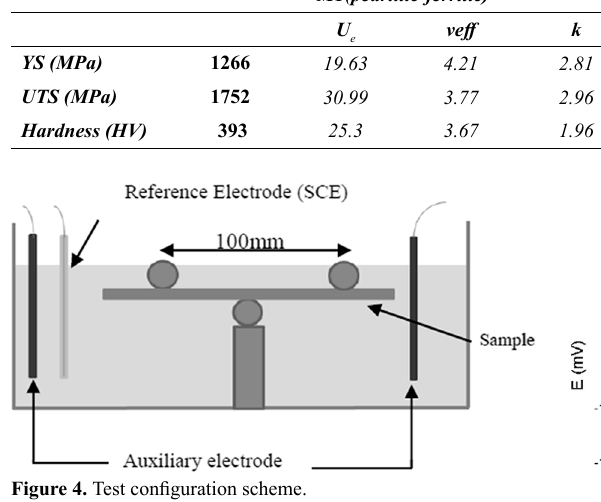
Table 2. Results for mechanical properties from M1 and M2 steels, where: σe = Yield strength; UTS=Ultimate tensile strength; Ue = Expanded Uncertainty; νeff = Degree of freedom; k = coverage factor. M1(pearlitic-ferritic)